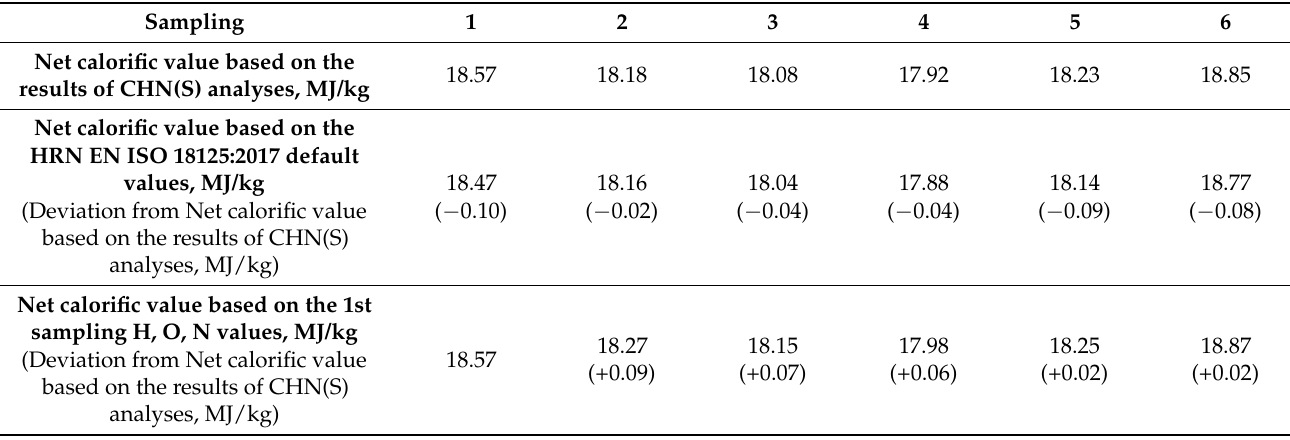
Table 5. Results of the net calorific value calculation of beech energy